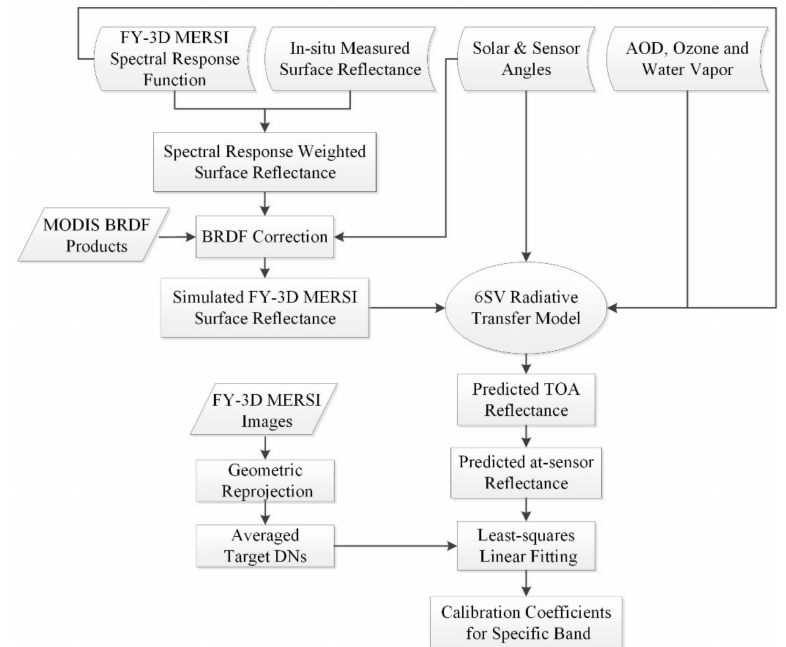
Figure 5. The flow chart of the adopted method of reflectance-based vicarious calibration with bidirectional reflectance distribution function (BRDF)